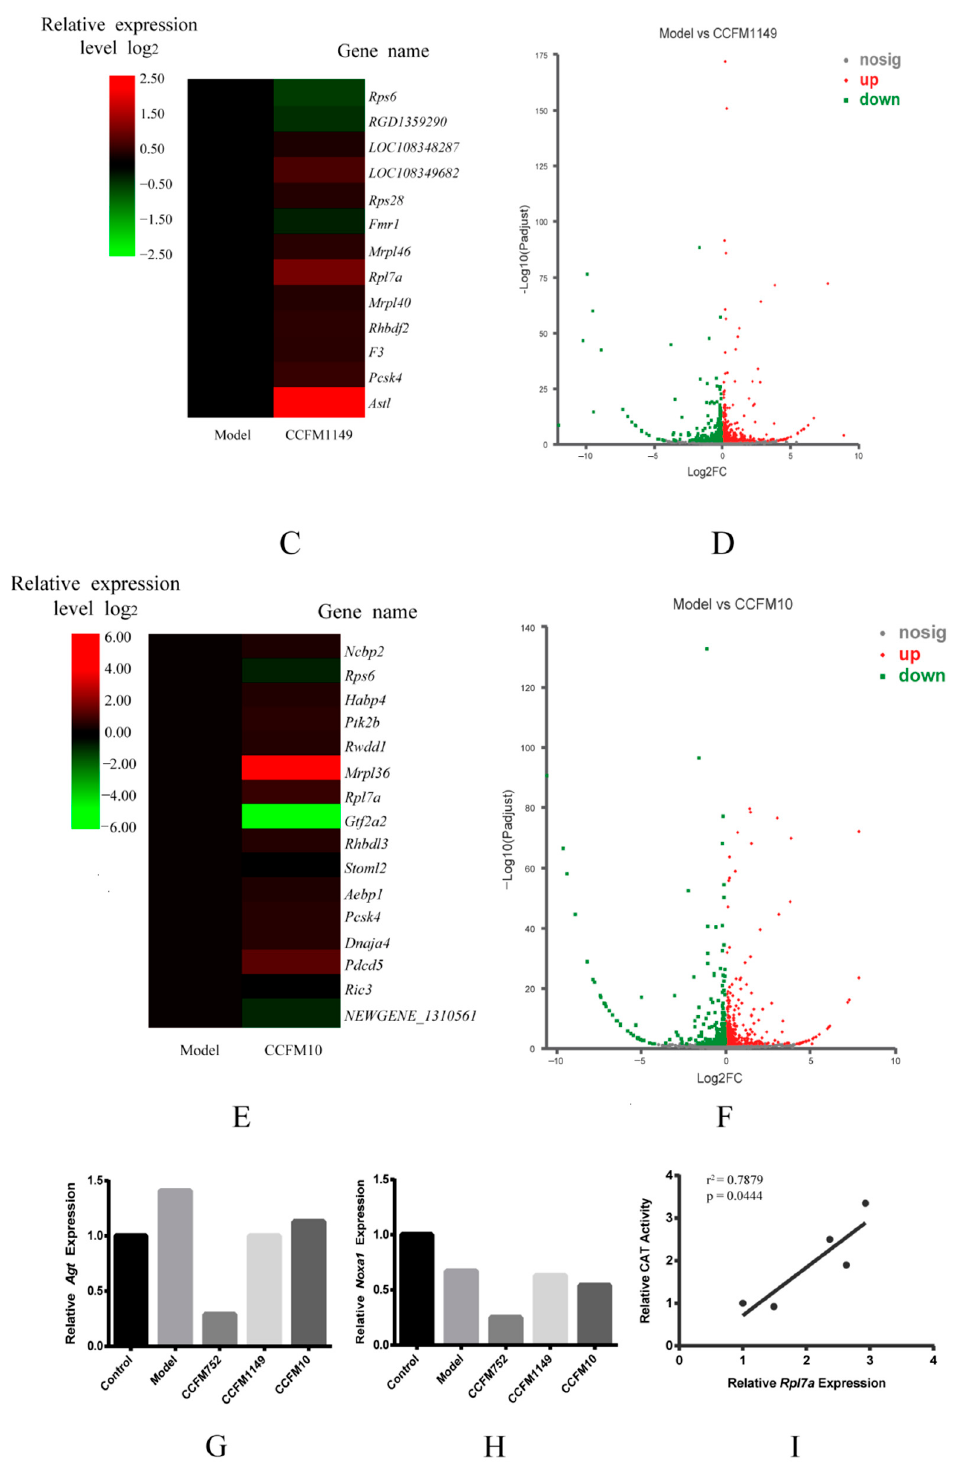
Figure 4. Transcriptional profiles and relative gene expression levels of A7R5 cells. ( A ) Heatmap of differentially expressed genes (DEG) relevant to protein biosynthesis between the model and CCFM752 group. ( B ) Volcano plot of transcriptomic differences between the model and CCFM752 group. ( C ) Heatmap of DEG relevant to protein biosynthesis between the model and CCFM1149 group. ( D ) Volcano plot of transcriptomic differences between the model and CCFM1149 group. ( E ) Heatmap of DEG relevant to protein biosynthesis between the model and CCFM10 group. ( F ) Volcano plot of transcriptomic differences between the model and CCFM10 group. ( G ) Relative expression of angiotensinogen in different groups. ( H ) Relative expression of NADPH oxidase activator 1 (Noxa1) in different groups. ( I ) Linear regression analysis of intracellular CAT activity and ribosomal protein L7a (Rpl7a) expression in different groups.